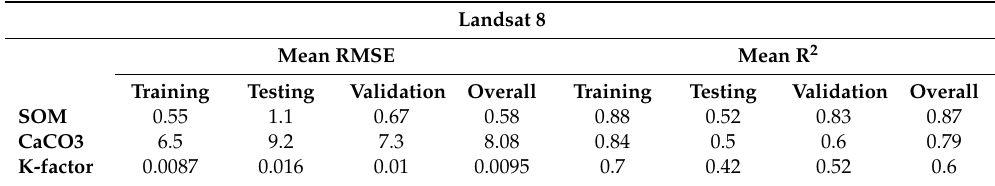
Table 3. Statistics of R 2 and root-mean-square error (RMSE) concerning the performance of the MLP artificial neural network (ANN) algorithm in the Landsat 8 data.